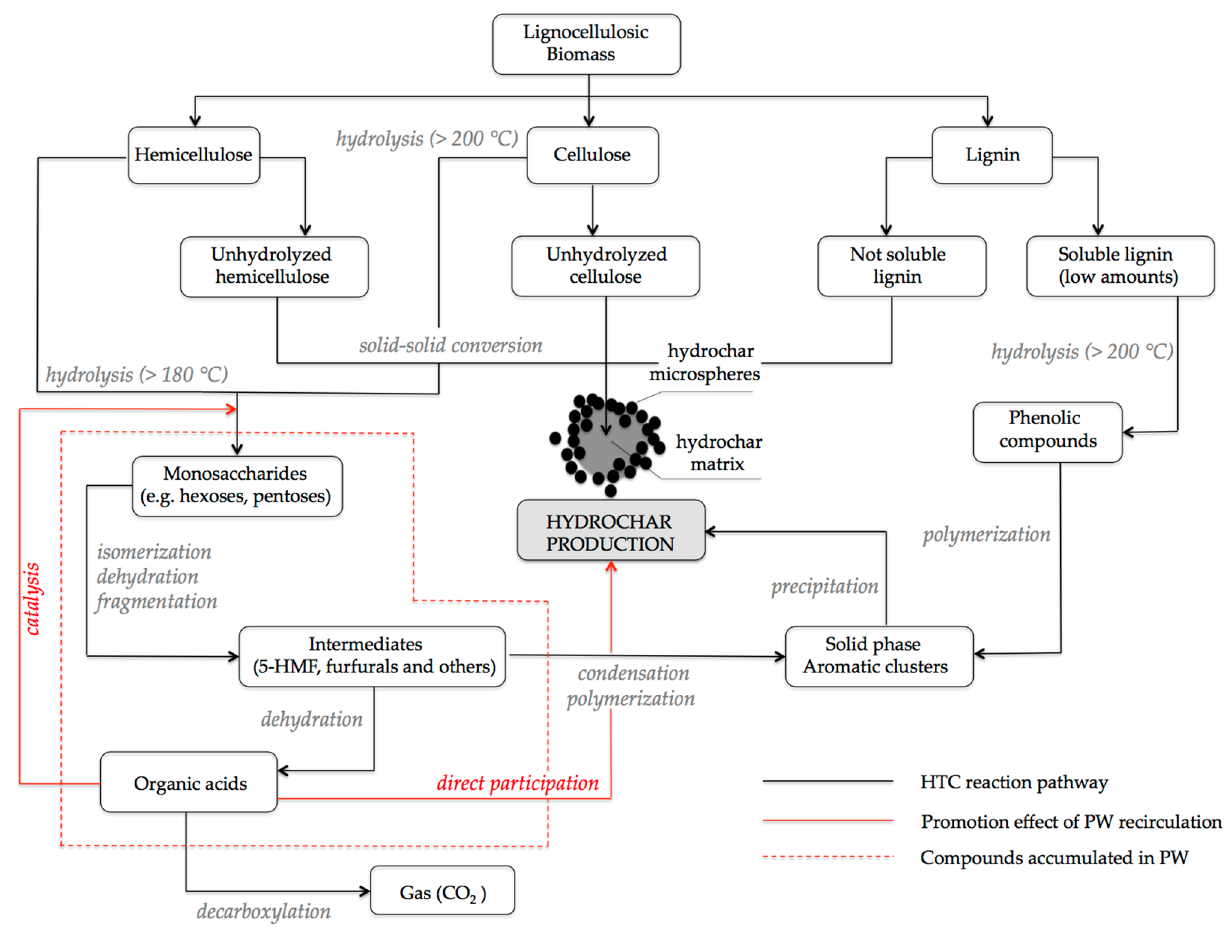
Figure 2. Hydrochar production during HTC process with recirculated PW (summarized from [43,44,46,57]).